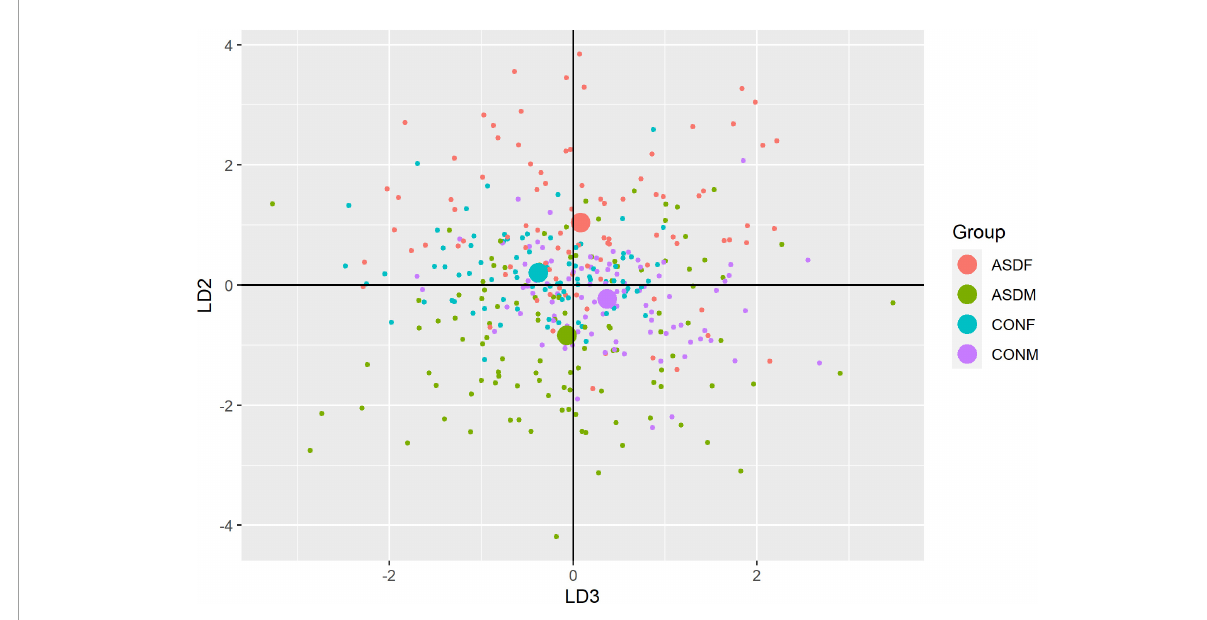
FIGURE3 Linear discriminant axis 2 plotted against linear discriminant axis